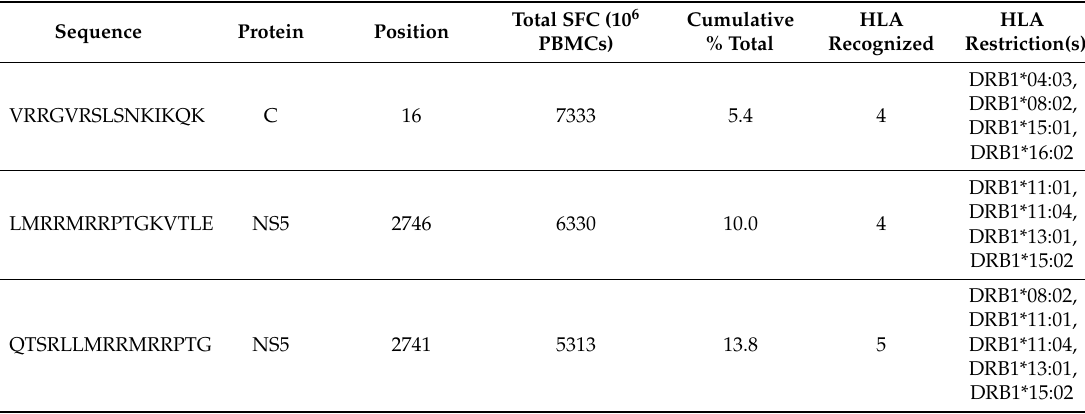
Table 1. Most dominant peptides are recognized by YF-17D vaccinees. PBMCs, peripheral blood mononuclear